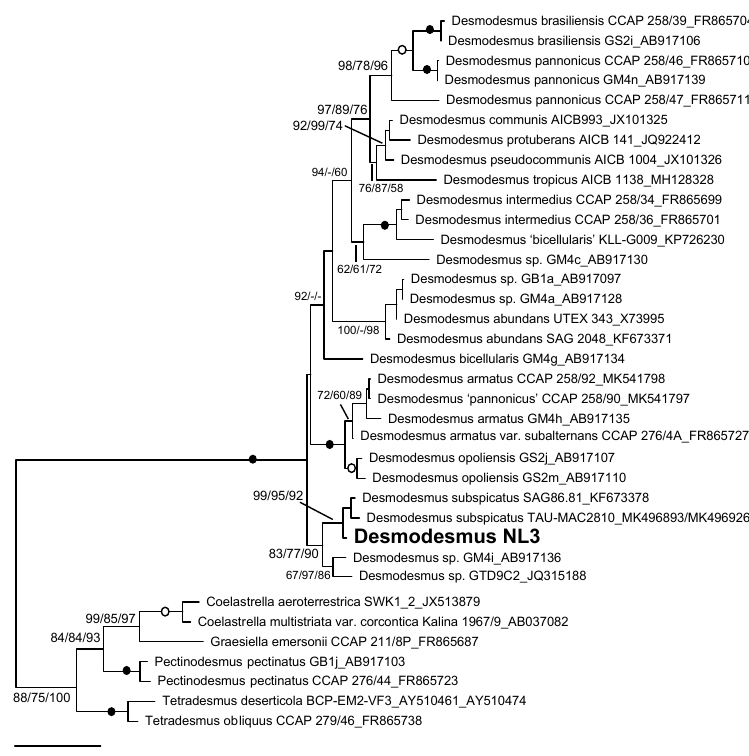
Figure 2. Phylogenetic position of isolate nl3 within Scenedesmaceae. The phylogenetic tree was built on a selected set of microalgal rDNA (18S–ITS1-5.8S-ITS2) sequences available in GenBank, using maximum likelihood (ML), neighbor-joining (NJ) and maximum parsimony (MP). Bootstrap values after 1000 replicates are indicated at nodes for ML/NJ/MP. Filled and open circles indicate 100 or >95% BV support with all methods, respectively; hyphen, node not supported.